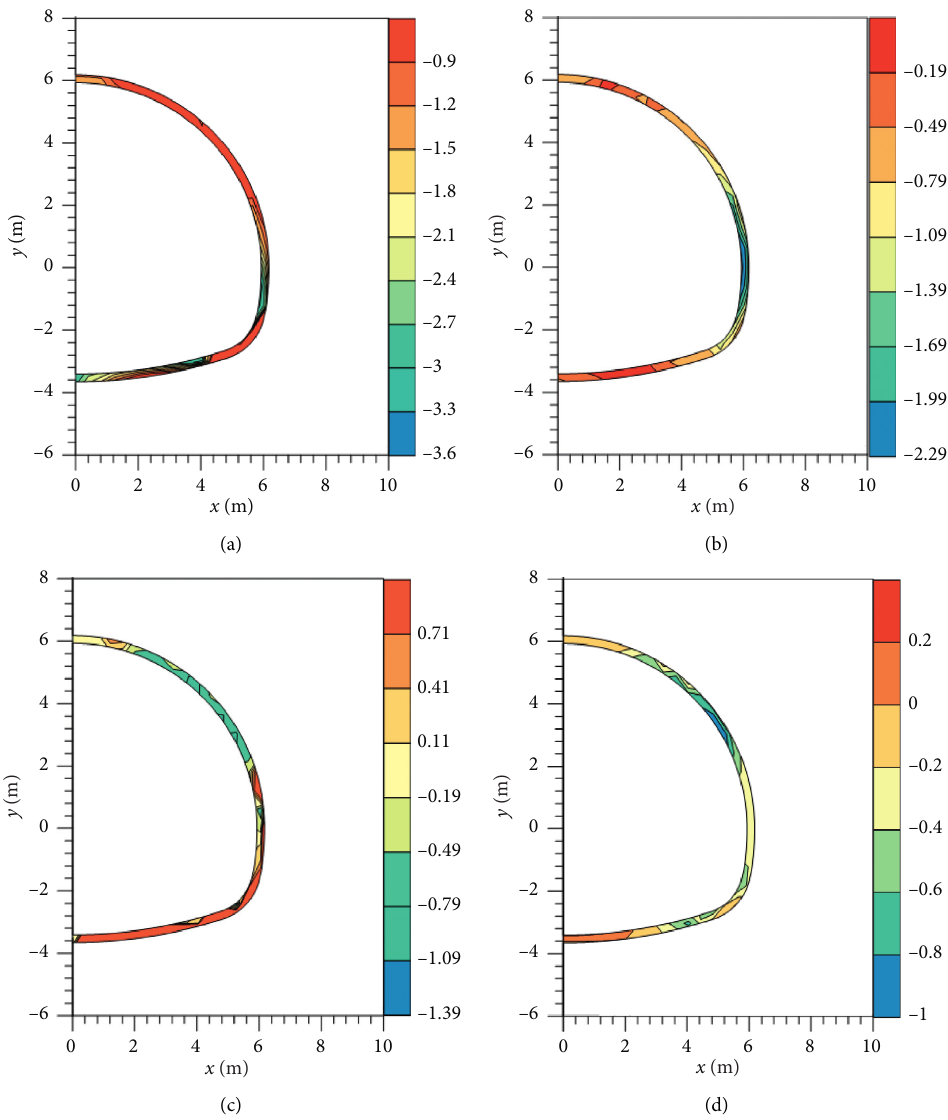
Figure 6: Stress regimes of the primary lining structure at D1 in WTIL on April 15 in 5 years of the operation period of the tunnel. (a) MAPS in cold season. (b) MAPS in warm season. (c) MIPS in cold season. (d) MIPS in warm